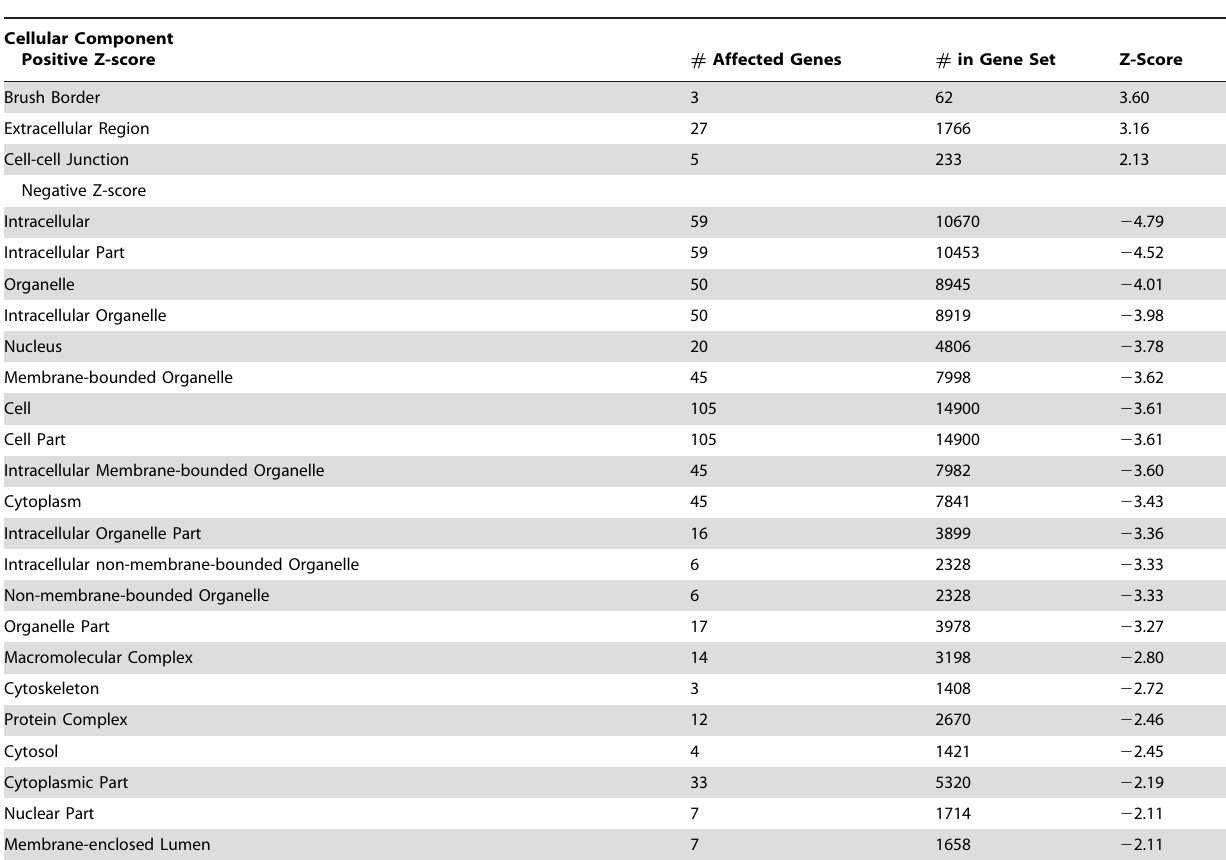
Table 3. Changes in Brain Expression with CCI and mHW: Cellular